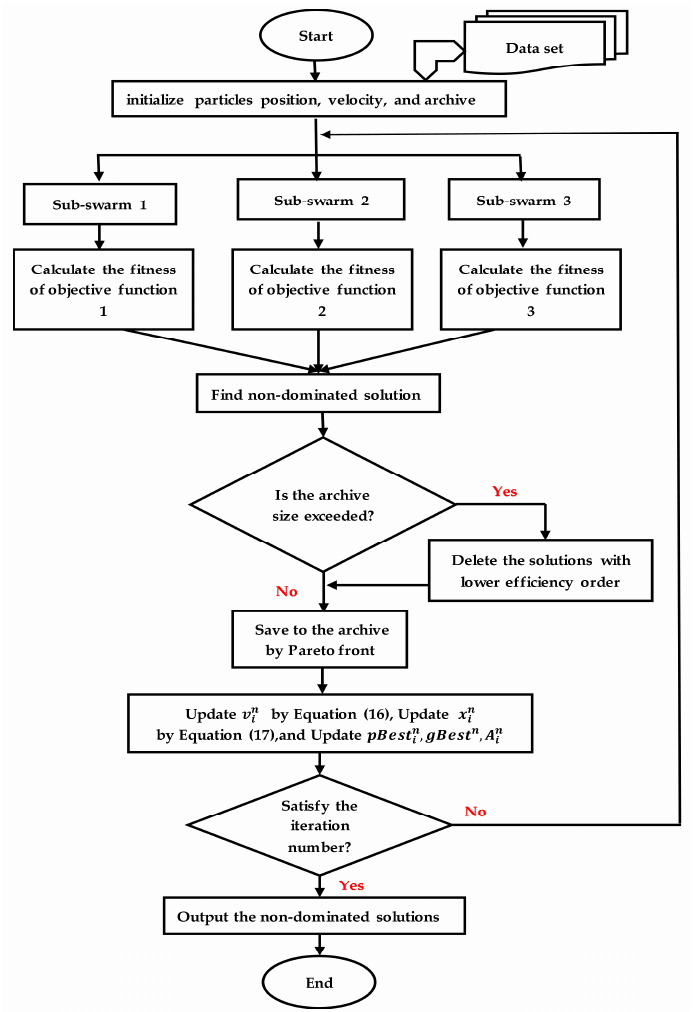
Figure 2. The proposed co-evolutionary multi-objective particle swarm optimization (CMPSO) algorithm for maintenance optimization.